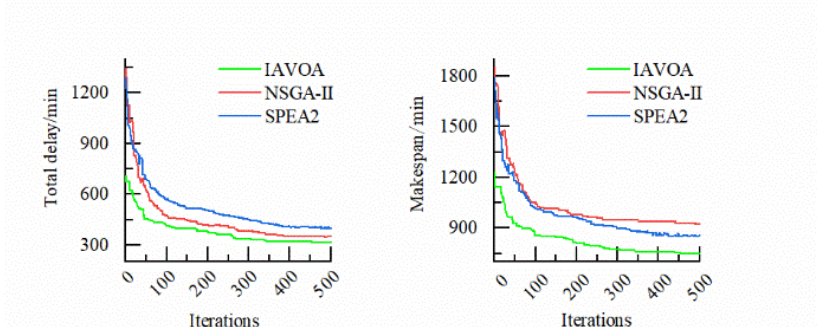
Figure 12. Convergence graph of DMK12.